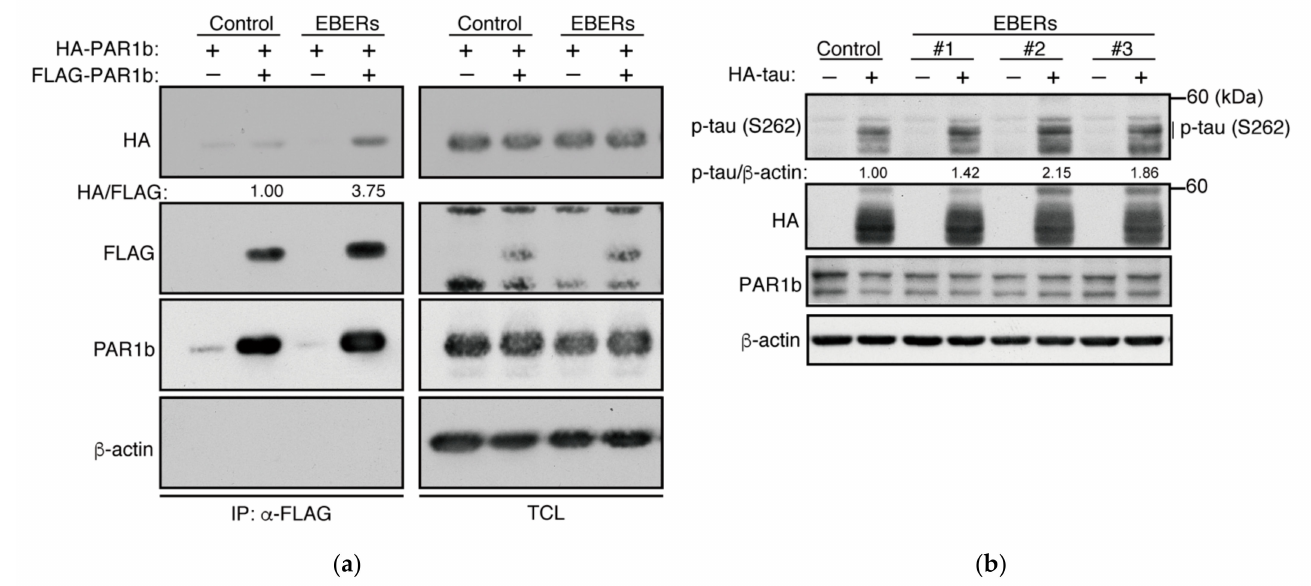
Figure 6. EBERs from Epstein–Barr virus can promote PAR1b multimerization and enhance its kinase activity. ( a ) Multimerization of PAR1b in AGS cells stably expressing EBERs. AGS cells stably expressing EBERs were transiently transfected with expression vectors for FLAG-tagged PAR1b and HA-tagged PAR1b and immunoprecipitation was performed. ( b ) Expression of EBERs can potentiate the phosphorylation of tau at S262. HA-tau expression vectors were transiently transfected to three independent clones of AGS cells stably expressing